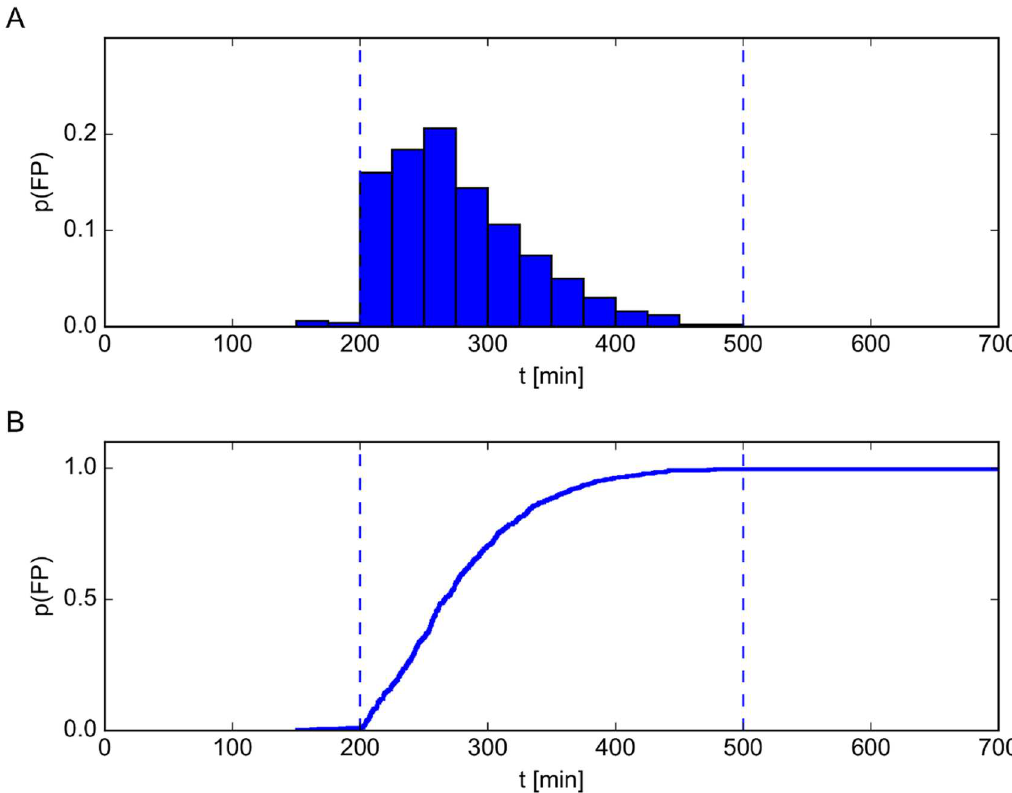
Fig 6. Probability distribution of the first peak in long mRNA abundance and survival function. We simulatedan SOS signalby temporarilyup-regulating the LexA auto-cleavage parameter from c p = 0.0 to c p = 6.0 betweenthe